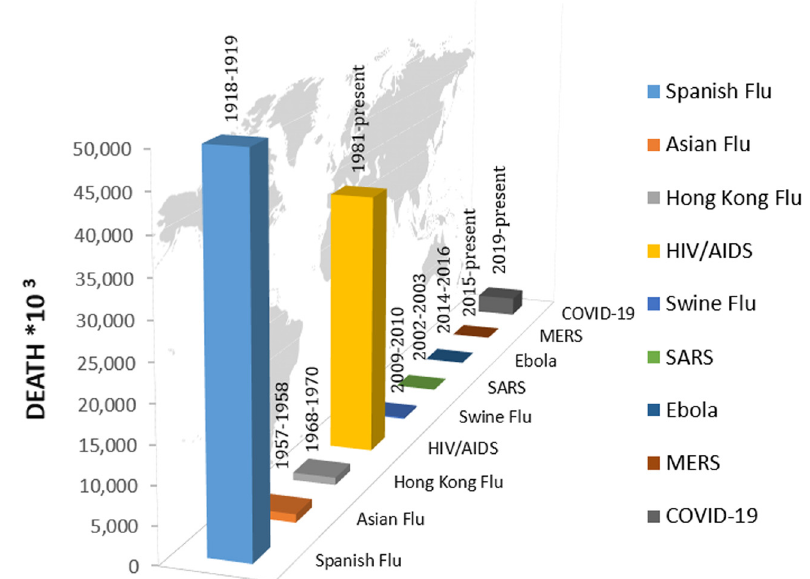
Figure 1: The death rate of coronavirus and other infectious diseases